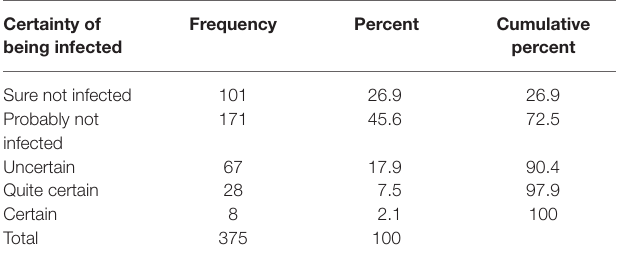
TABLE 2 | Distribution of participants based on the certainty of being infected by